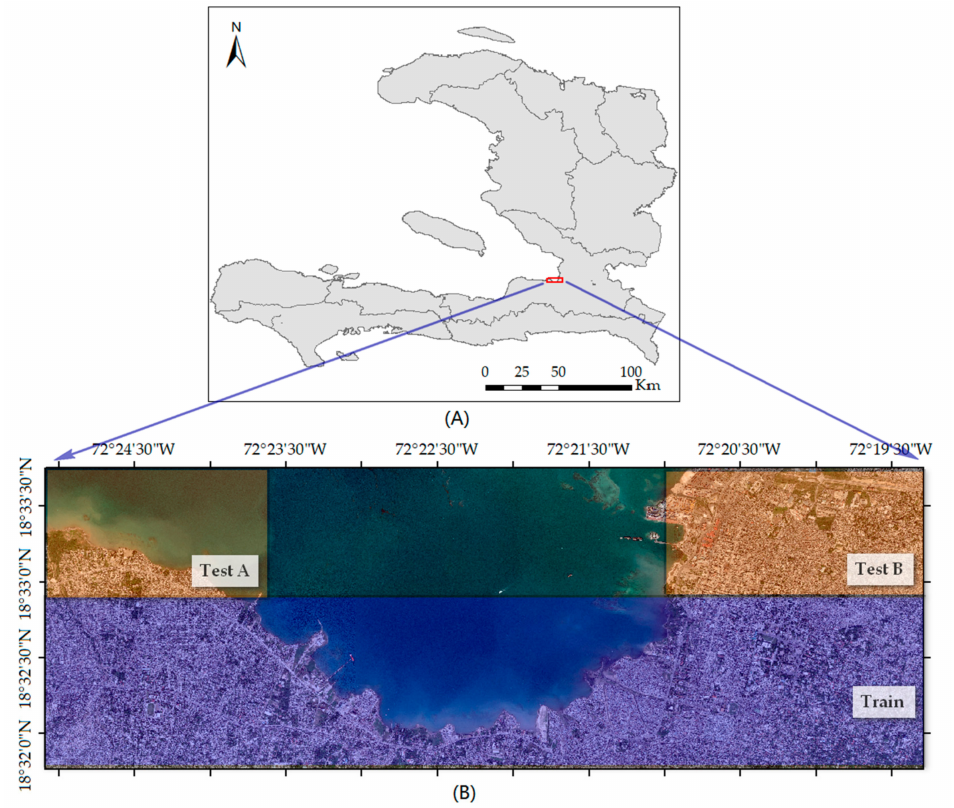
Figure 1. Location of the study area and regions for train and test datasets.